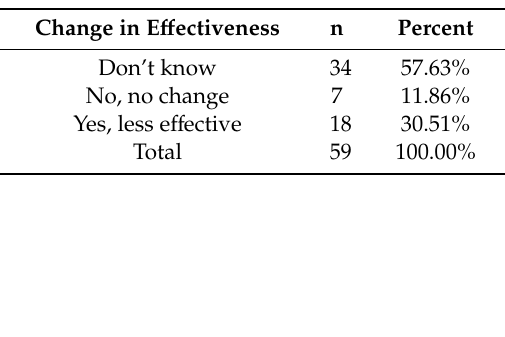
Table 4. Owners perception on the past and present e ff ectiveness of ectoparasiticides used on dogs and